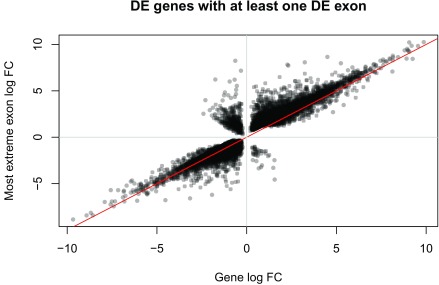
Log fold change (FC) for DE genes compared against the most extreme exon log FC among exons that are DE for the given gene.